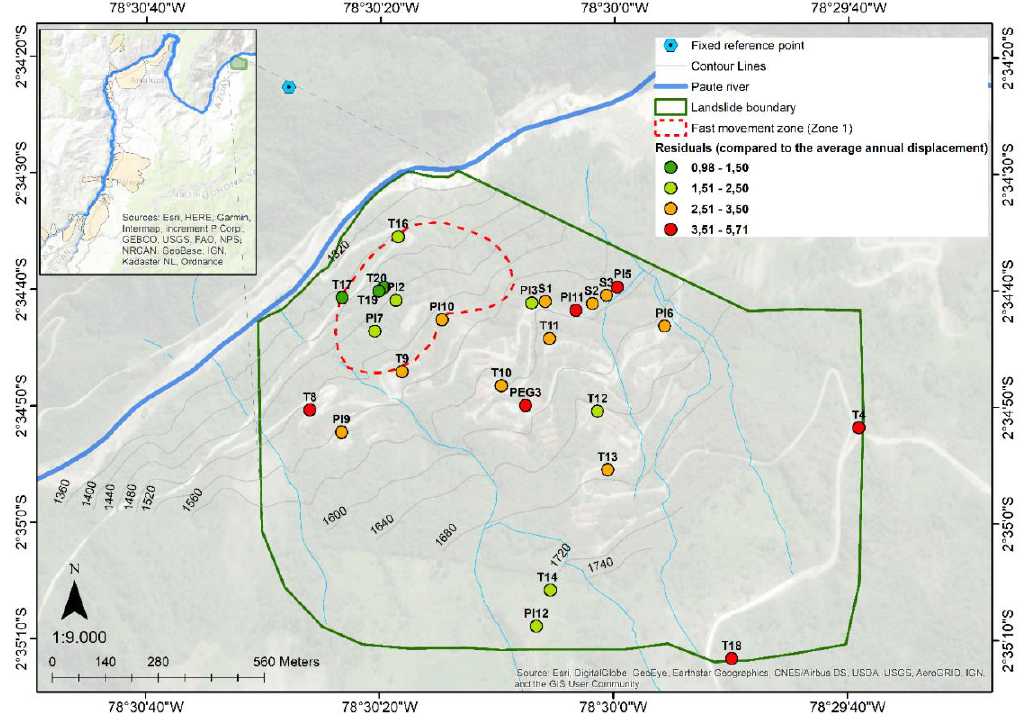
Figure A6. Plan view of the residuals compared to the annual average displacement in Guarumales.